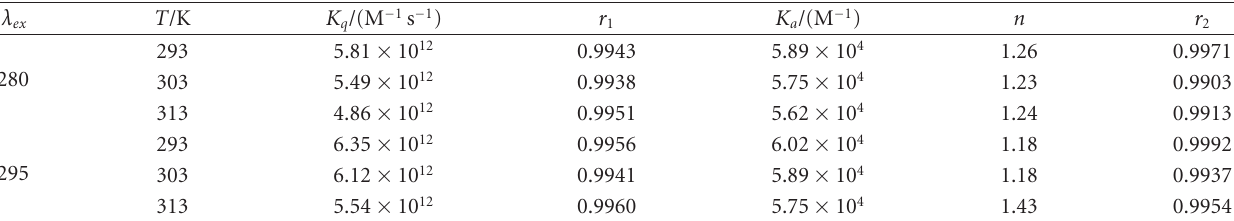
Table 1: Quenching reactive parameters of BSA and Avelox at di ff erent temperatures.